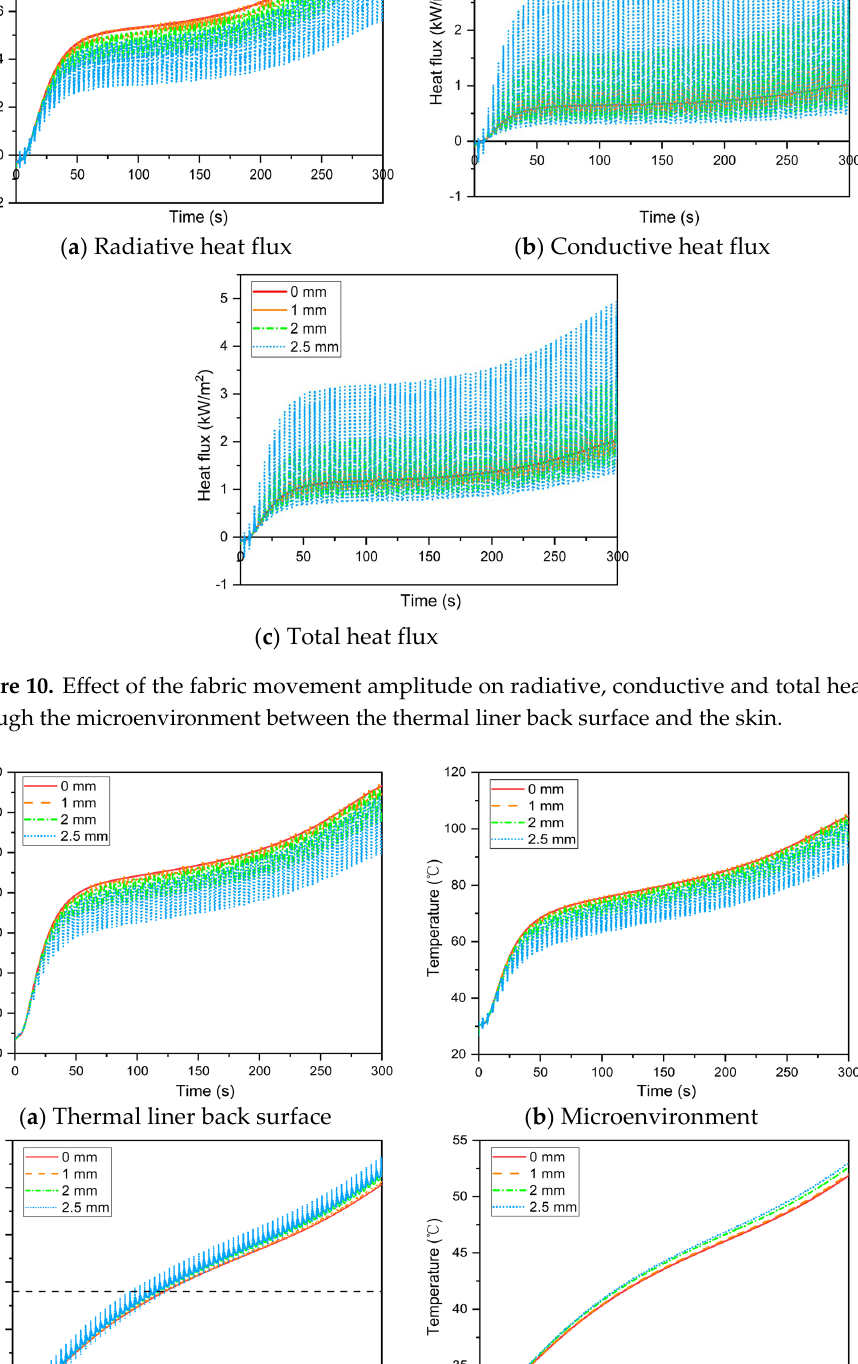
Figure 11. Effect of fabric movement amplitude on the temperature distribution in the skin–microenvironment–fabric system.